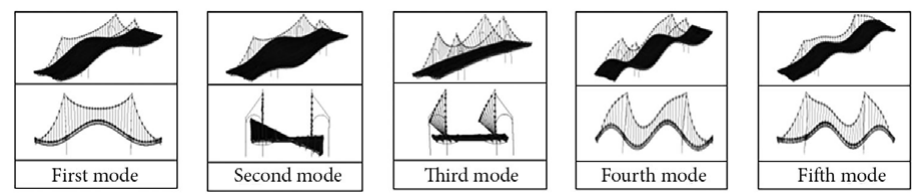
Fig. 7. Set up for ambient excitation test